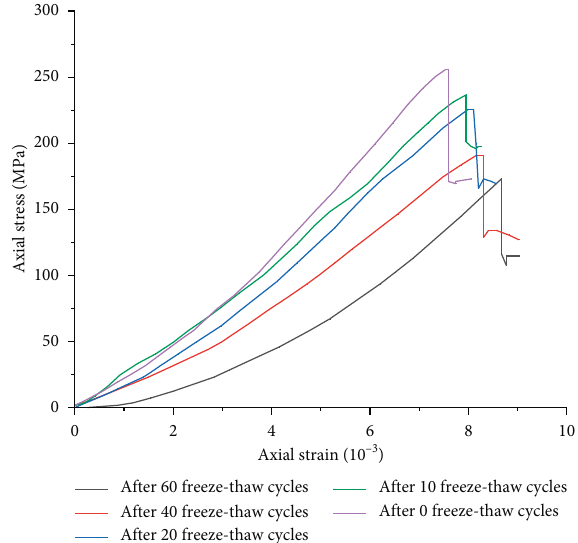
Figure 8: Stress-strain curves of the samples under different freeze- thaw